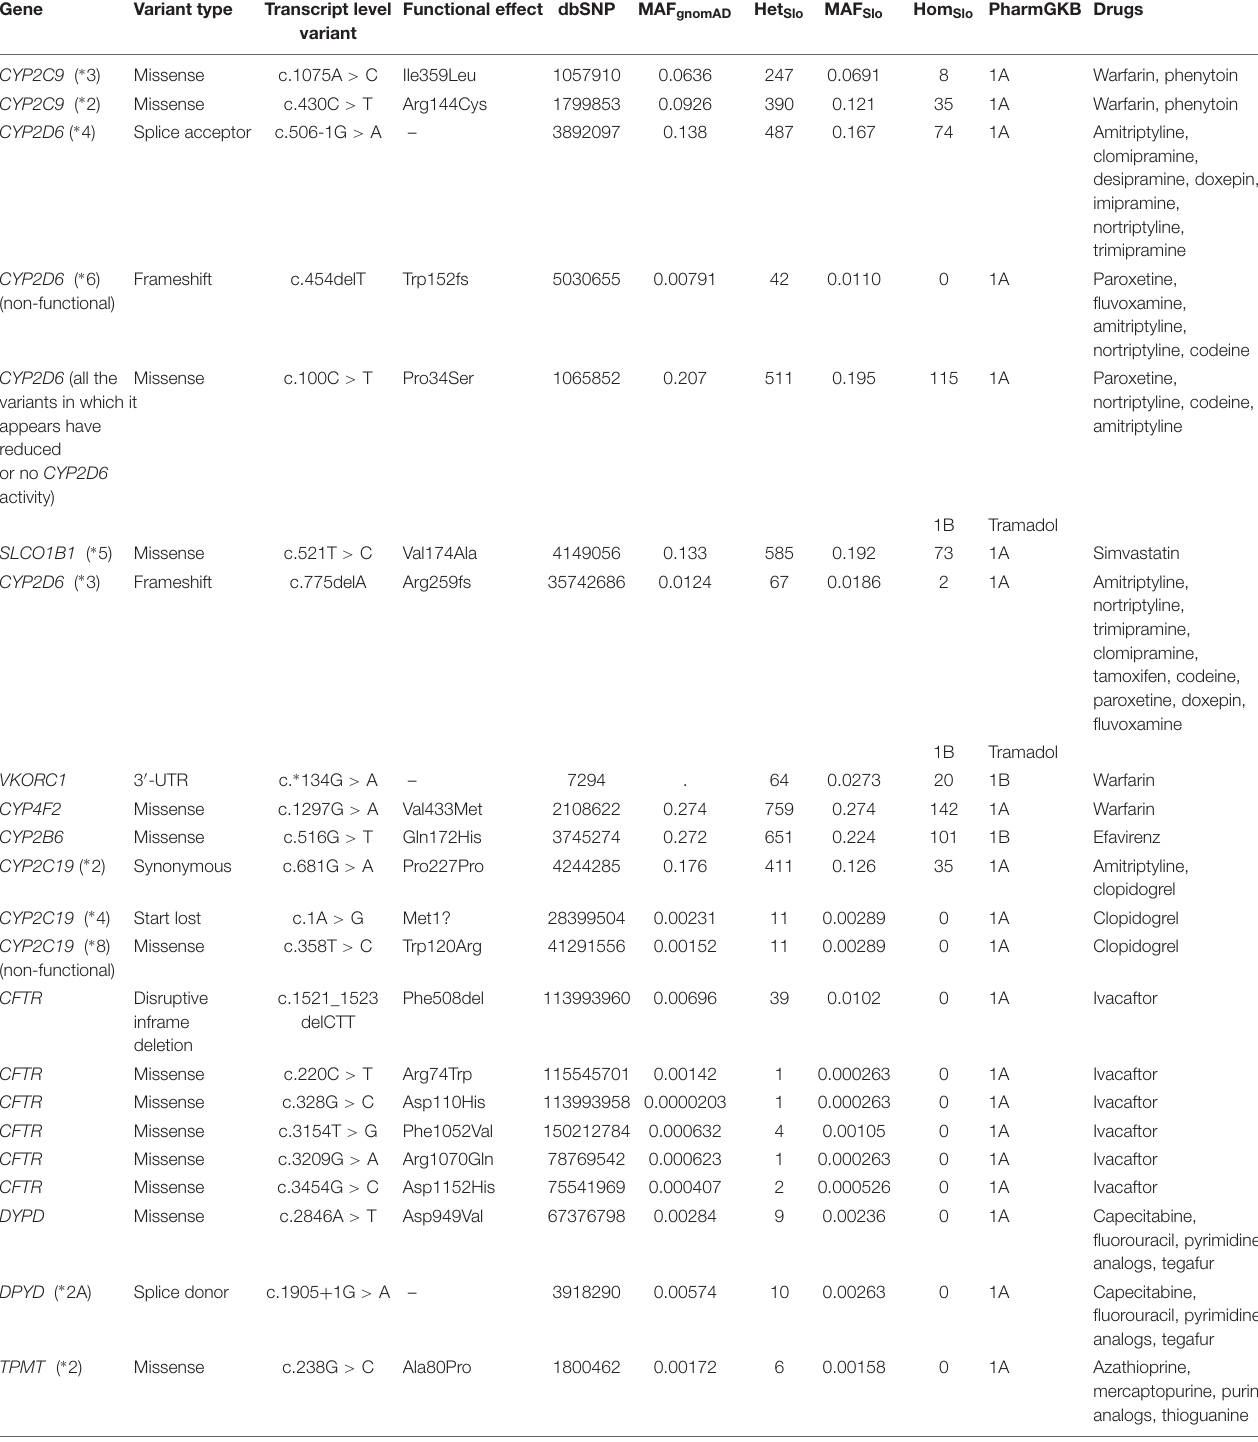
TABLE 2 | Variant-drug pairs with 1A or 1B clinical annotation according to Pharmacogenomics Knowledgebase (PharmGKB). Gene Variant